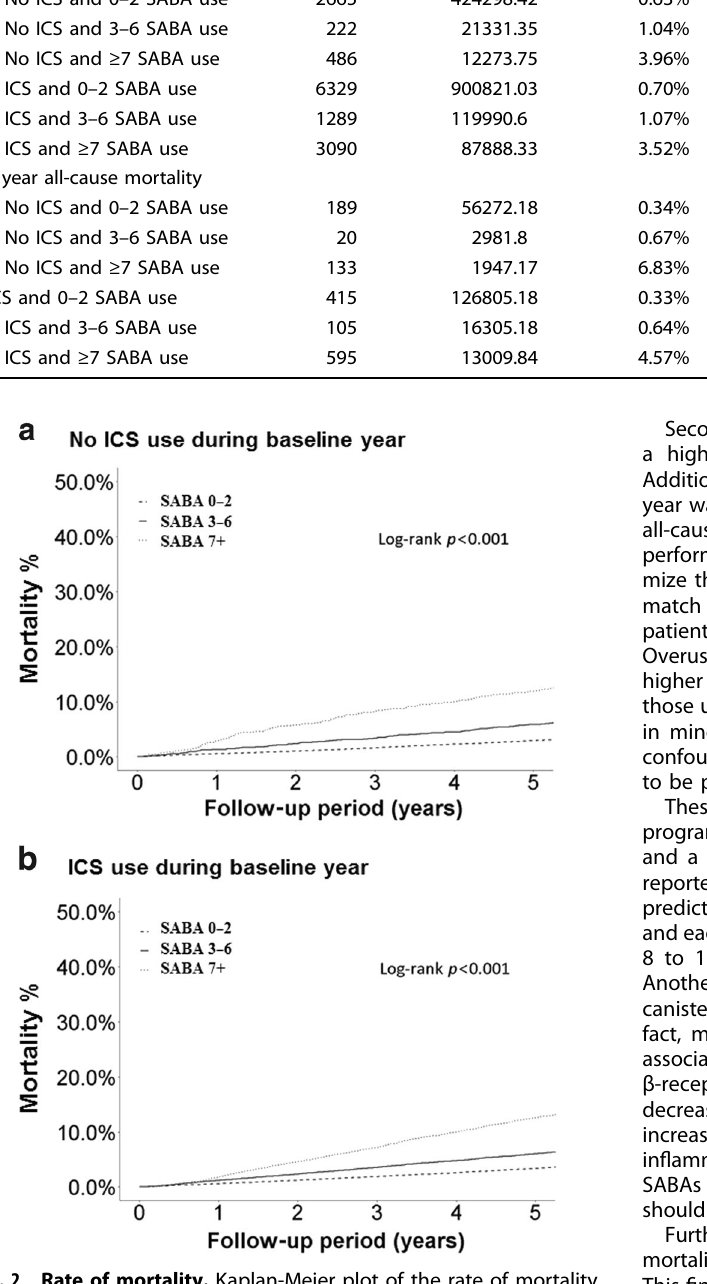
Fig. 2 Rate of mortality. Kaplan-Meier plot of the rate of mortality by baseline SABA use among non-ICS uses ( a ) and ICS-uses ( b